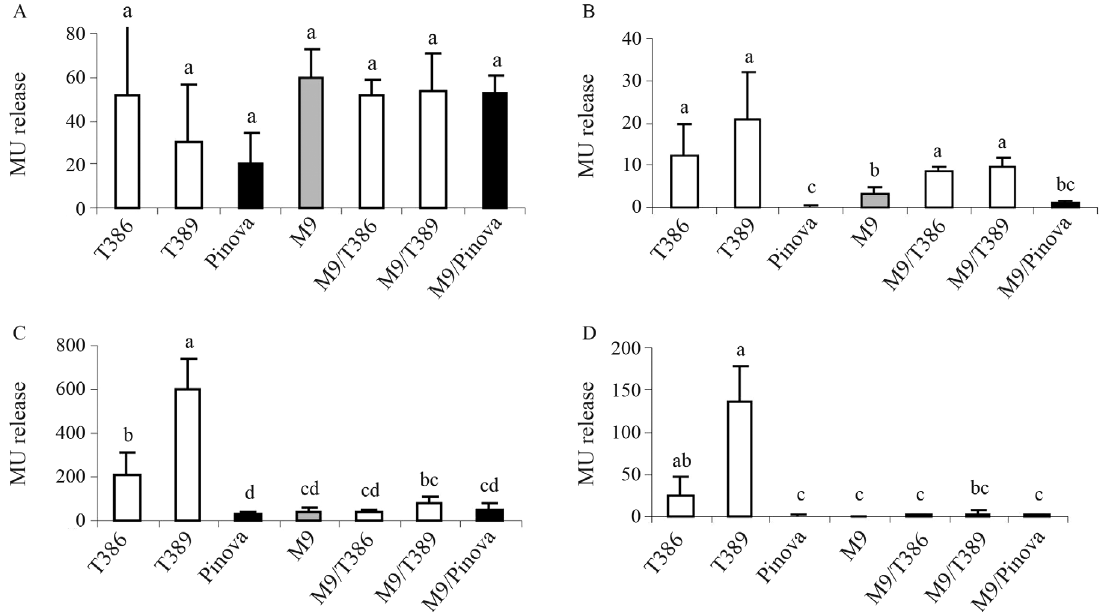
Figure 4 - Chitinase activity of tissues from greenhouse-grown trees. (A) Exochitinase and (B) endochitinase activities in the youngest leaves, and (C) exochitinase and (D) endochitinase activities in fine roots. Enzyme activities (MU release) were expressed in pmol/mg protein/min and the columns rep- resent the mean (cid:3) SD of four independent determinations. ANOVA of log transformed data revealed significant differences in the leaf endochitinase (F: 41.4145, p < 0.0001), root exochitinase (F: 25.6303, p < 0.0001) and root endochitinase (F: 18.6769, p < 0.0001) activities among the varieties/lines. Dif- ferent letters above bars indicate significant differences (p < 0.05) based on Tukey’s Honestly Significant Difference test.